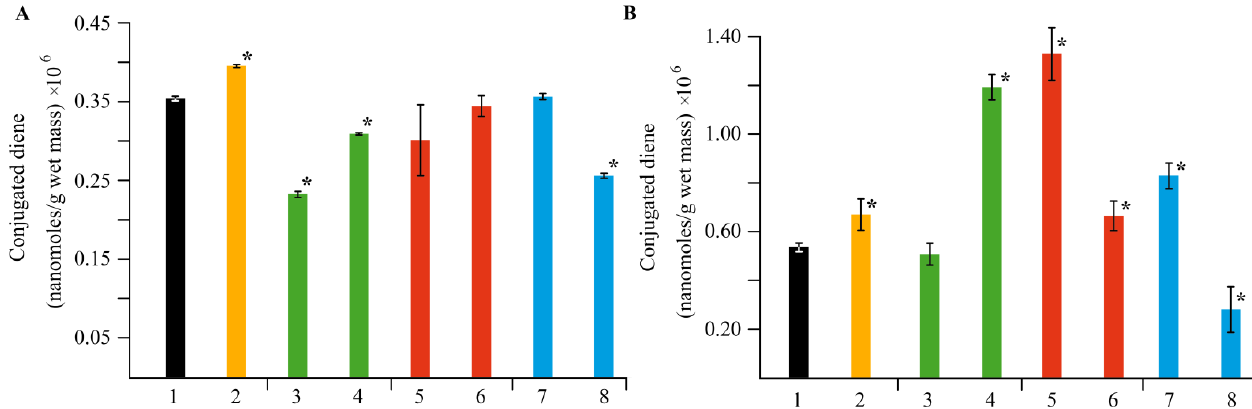
Figure 11. Effect of NC treatments on the content of DCs in potato leaves ( A ) and roots ( B ), in comparison with the control group in vitro, as well as in plants infected by Cms pathogen; (1)—control, (2)—plants infected by Cms , (3)—AG-Mn without Cms , (4)—infected plants in the presence of AG-Mn, (5)—AGS-Mn without Cms , (6)—infected plants in the presence of AGS-Mn, (7)— κ -CG-Mn without Cms , (8)—infected plants in the presence of κ -CG-Mn; * p ≤ 0.01 compared to the control according to the Mann–Whitney test.